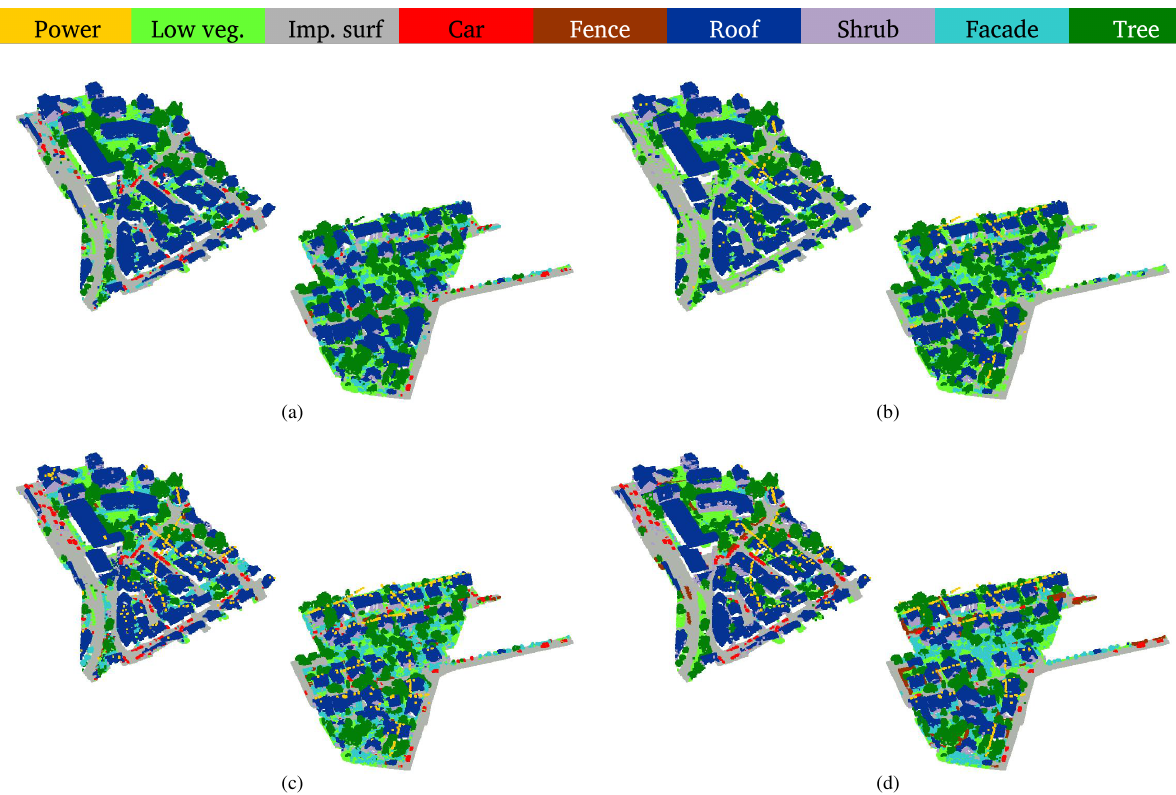
Figure 4. Illustration of classification map of the ISPRS dataset. (a), (b), (c), and (d) represent the DBS, FRS, CRS, and ground truth, respectively.